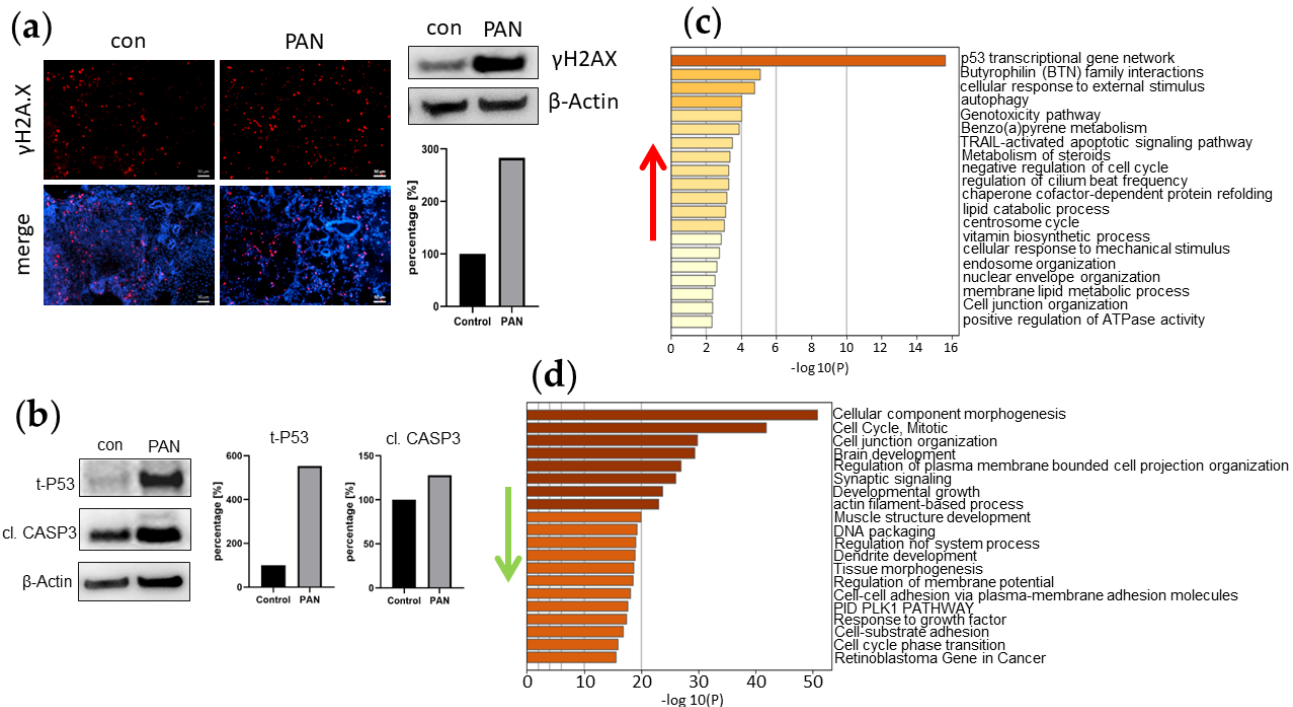
Figure 5. PAN treatment induces DNA damage in kidney organoids. ( a ) Elevated expression of γH2A.X (red) in PAN-treated kidney organoids UMK1. Nuclei were stained with Hoechst33342 (blue). Scale bar depicts 50 µm. ( b ) Elevated expression of t-P53 and cleaved Caspase 3 in PAN-treated kidney organoids UMK1. ( c ) Upregulated enrichment clusters include cell damage. ( d ) Cell-cycle-related enrichment clusters were downregulated by PAN treatment.